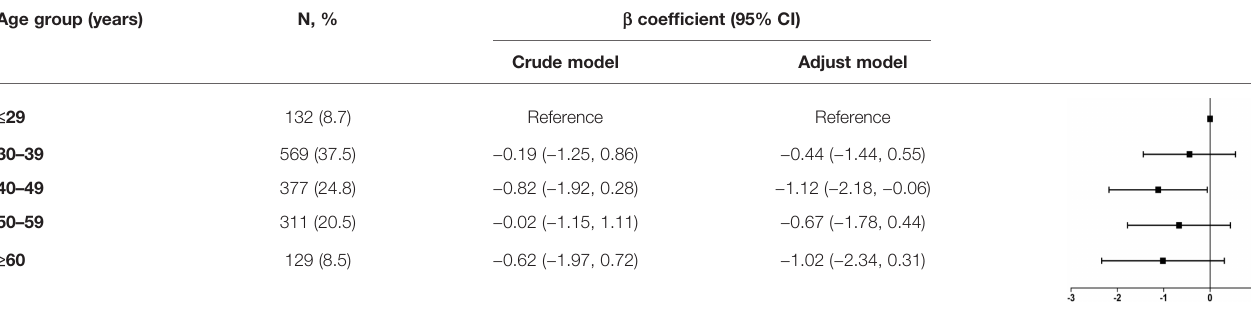
TABLE 2 | Association of whole blood NAD + contents with aging in total